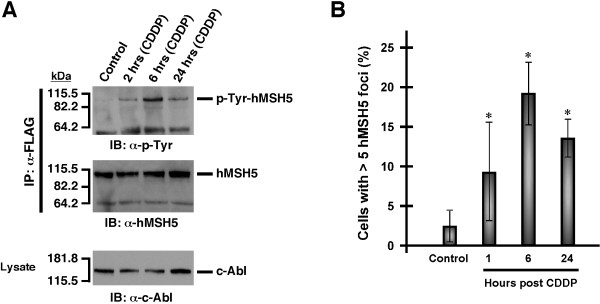
Cisplatin triggered c-Abl-mediated hMSH5 tyrosine phosphorylation and hMSH5 nuclear foci formation. (A) Cisplatin treatment led to hMSH5 tyrosine phosphorylation. 293T/f-hMSH5 cells were transiently transfected with myc-c-Abl and subjected to 20 μM cisplatin treatment at 48 hrs post-transfection. Cell lysates were then prepared at indicated time points, and the status of tyrosine phosphorylation of immunoaffinity-purified f-hMSH5 was analyzed by Western blotting. Untreated cells were used as controls. (B) Time course of cisplatin-induced hMSH5 nuclear foci formation. 293T cells were treated with 10 μM of cisplatin for 2 hrs and hMSH5 foci were examined at 1, 6, and 24 hrs post-treatment. Untreated cells were included as controls. Cells containing five or more hMSH5 nuclear foci were quantified. Error bars represent standard deviations from the means of three independent measurements. Asterisks denote statistical significance (p < 0.05, Student t-test) In order to assess the role of hMSH5 tyrosine phosphorylation in this process, we determined the tyrosine residue that can be phosphorylated by c-Abl. To this end, Tyr-to-Phe mutations were introduced to the truncated c-Abl substrate hMSH5 cp-1 [10,29], and each of the resulting hMSH5 cp-1 mutants was co-expressed with c-Abl in BL21(DE3)-RIL cells and subsequently affinity-purified. Immunoblotting analysis of soluble fractions of cell lysates and the affinity-purified hMSH5 cp-1 mutant proteins demonstrated that Tyr-to-Phe mutation at hMSH5 Tyr742 resulted in a complete abolishment of tyrosine phosphorylation, demonstrating that hMSH5 Tyr742 is responsible for c-Abl-mediated phosphorylation (Figure 4A). It is of note that Tyr742 is conserved between human and mouse, and it is located within the hMSH5 domain that interacts with hMSH4 [29,30]. Consistent with this, hMSH5 tyrosine phosphorylation is known to negatively regulate its interaction with hMSH4 [10].